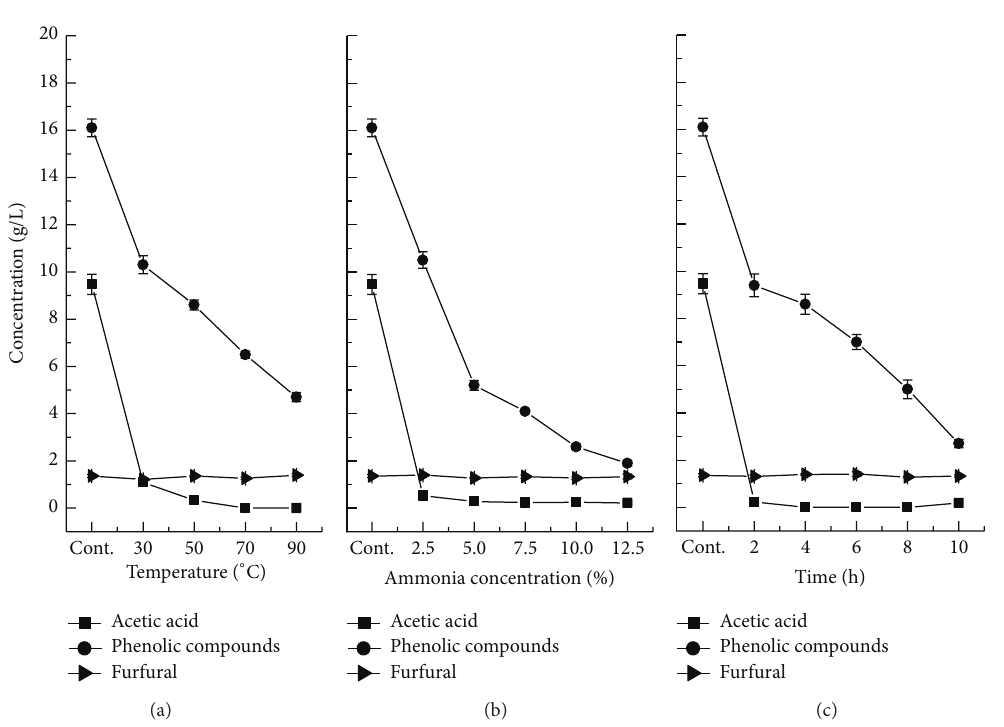
Figure 2: Influence of SAA conditions on the inhibitors concentration in the corncob acid hydrolysate ((a) the ammonia concentration in aqueous solution 5% and time 6h; (b) temperature 90 ∘ C and time 6h; (c) temperature 70 ∘ C and the ammonia concentration in aqueous solution